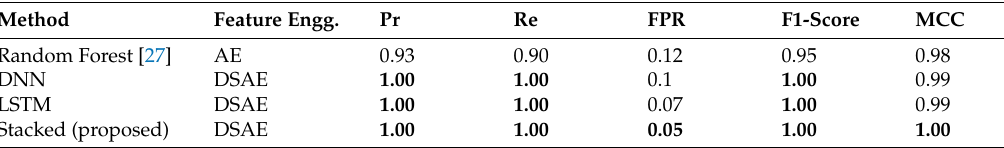
Table 13. Result of evaluation matrices w.r.t. existing approaches on the LITNET-2020 test set; best results are indicated with